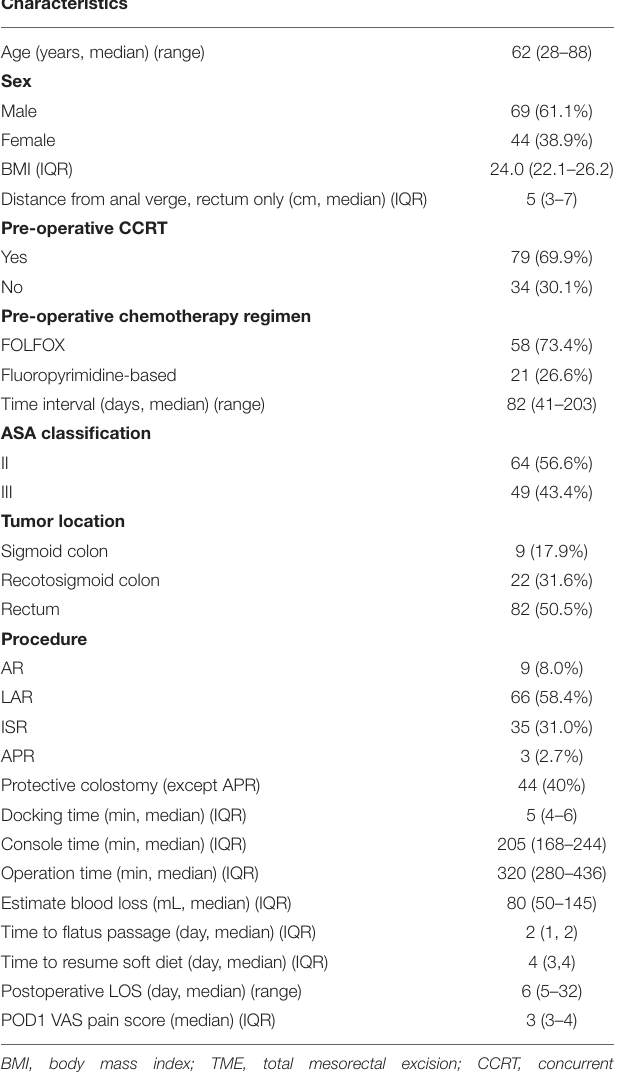
TABLE 2 | Postoperative complications of 113 patients with rectal or sigmoid colon cancer who underwent totally robotic-assisted TME with the high dissection and selective ligation